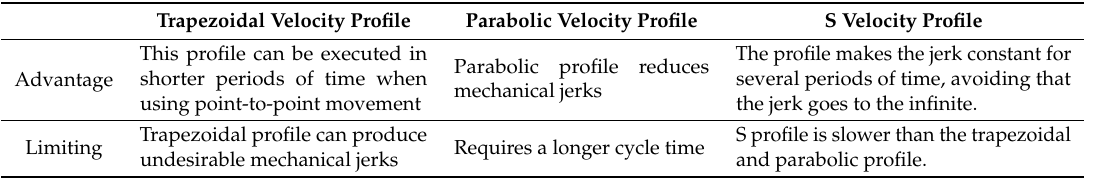
Table 1. General comparison of the velocity profiles.